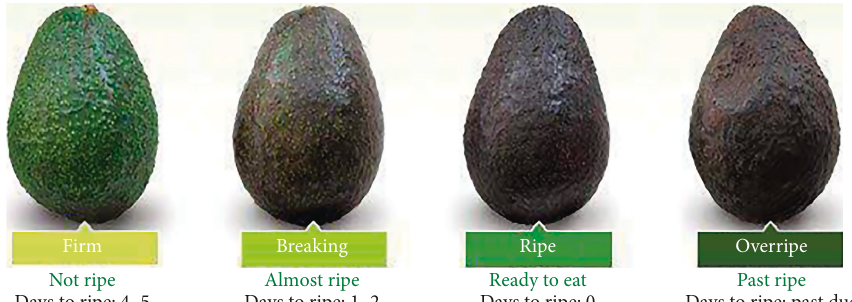
Figure 2: Ripening chart of